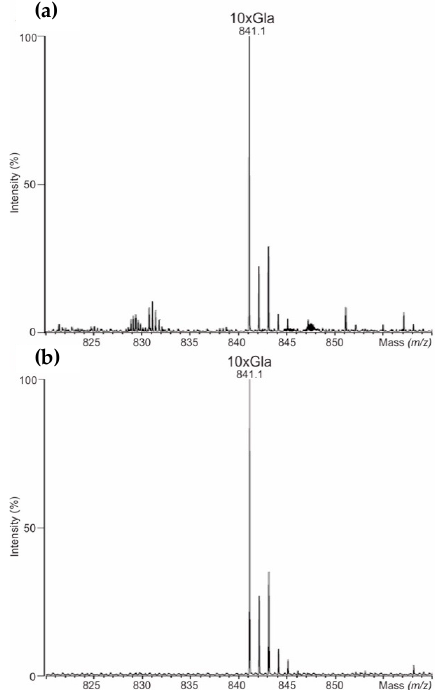
Figure 2. ( a ) Mass spectra of γ -carboxylation detected using liquid chromatography accurate mass spectrometry (UHPLC-QTOF-MS)/MS E in NovoSeven ® , and ( b ) AryoSeven™. Not assigned signals